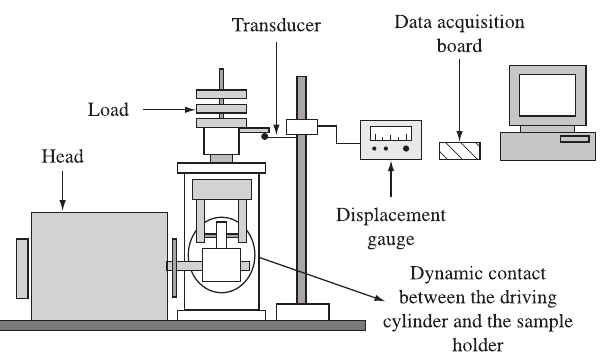
Figure 1. Schematic diagram of the test bench developed for this study